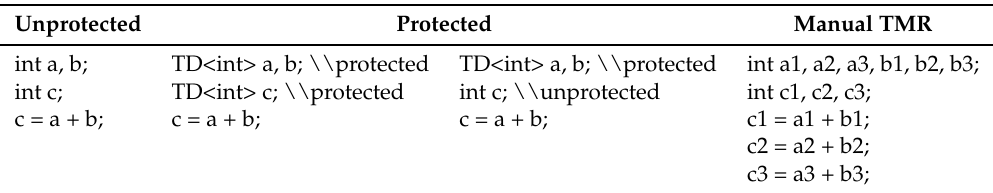
Table 3. Comparison of how to sum up two integer variables using different protection levels: original code, protection using our technique and manual TMR protection.